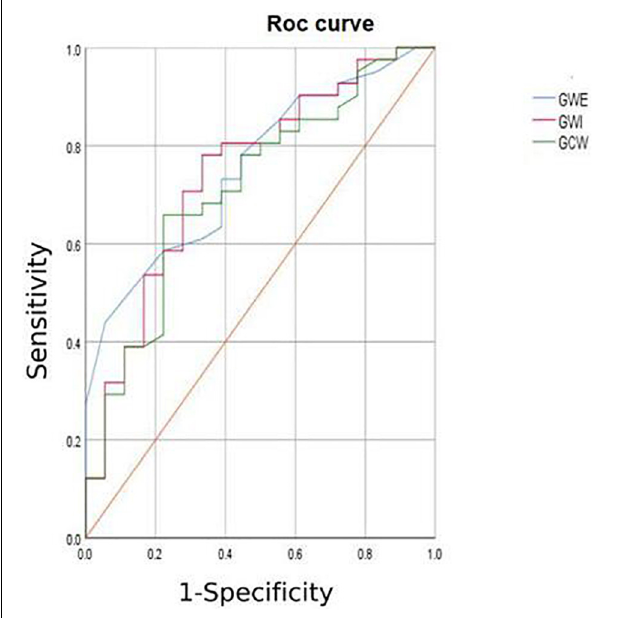
TABLE 4 | Specificity and sensitivity analysis in HCM.